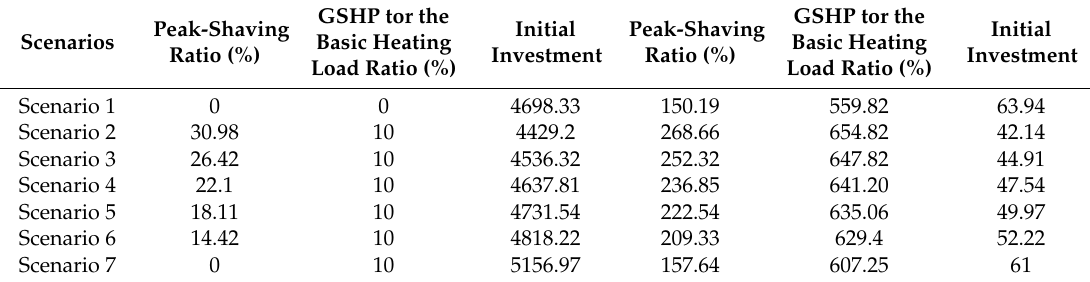
Table 3. Economic benefits of the integrated heating system that replaces the coal fired boilers.